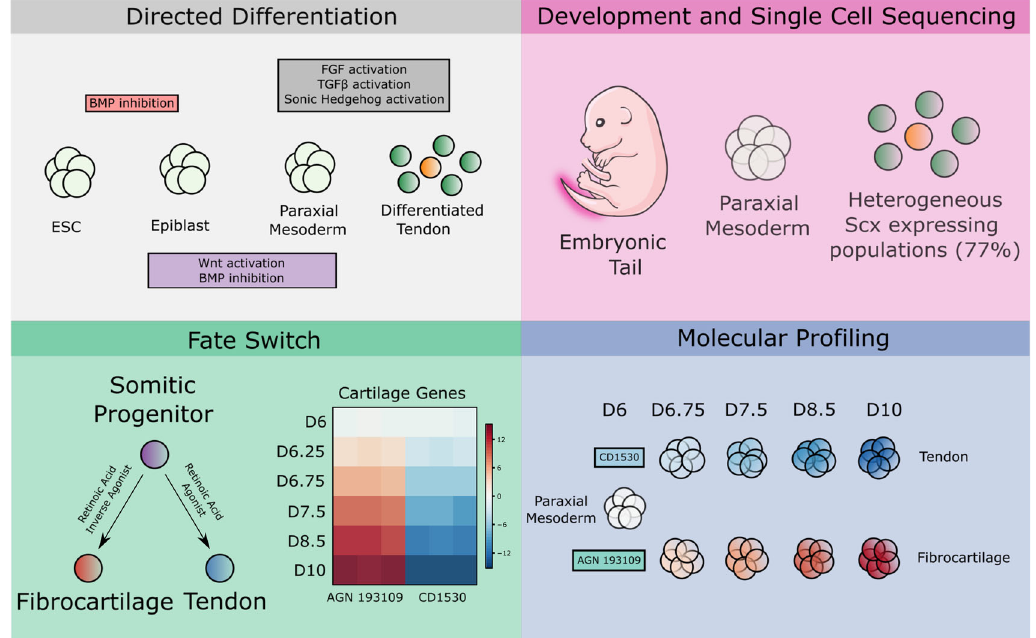
Fig. 8 Conceptual schematic highlighting key fi ndings. Directed differentiation inspired by developmental events was used to induce ScxGFP tendon cells. Single-cell RNA-seq identi fi ed distinctive tendon and fi brocartilage cells with high transcriptional similarity to in vivo embryonic counterparts. Retinoic acid signaling was identi fi ed as fate-switch regulator between tendon and fi brocartilage cells. Molecular pro fi ling identi fi ed regulators of tendon and fi brocartilage